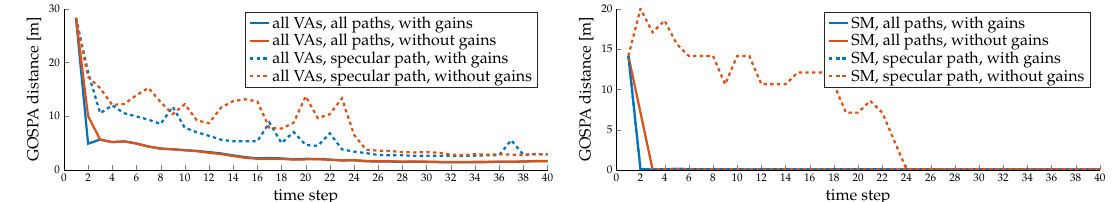
( b ) The comparison of mapping results for SM among four settings.